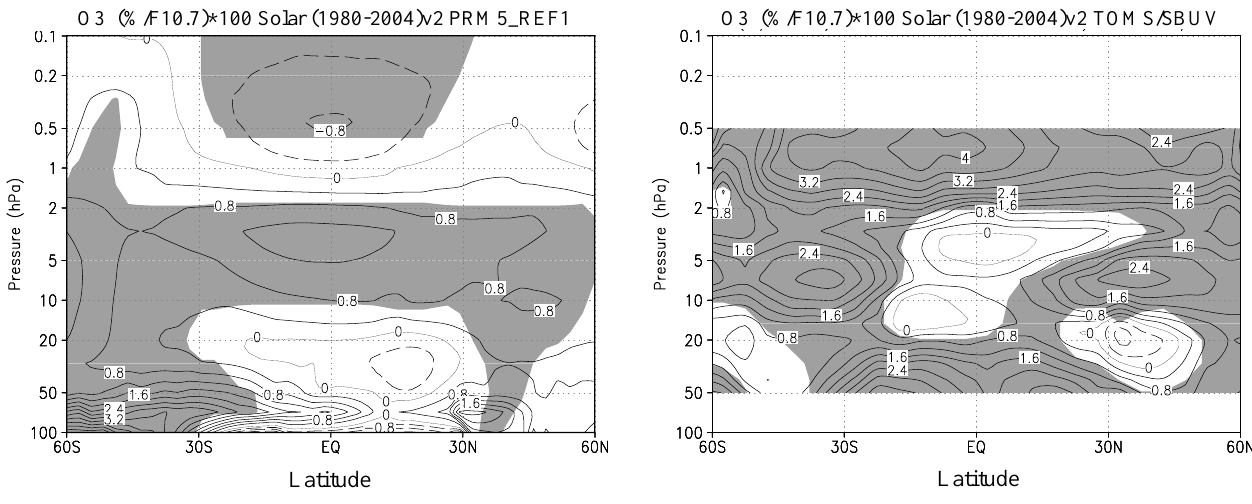
Fig.17 Same as in Fig.16 except for ozone in % per 100 solar units for the simulation (left) and observation (TOMS/SBUV) (right). Contour interval is 0.4.